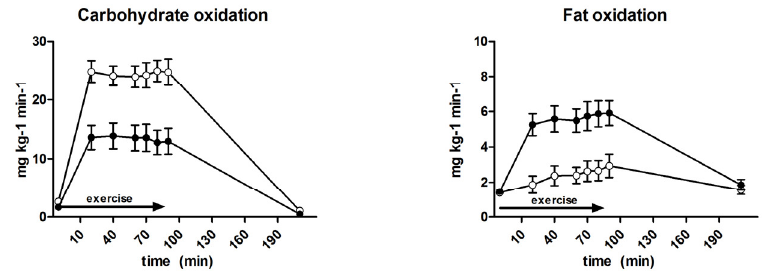
Table 2. Metabolic measures during last 30 min of exercise in GLUFRU and GLU. Values are mean (SEM). GLUFRU = glucose ‐ fructose co ‐ ingestion, GLU = glucose alone ingestion.